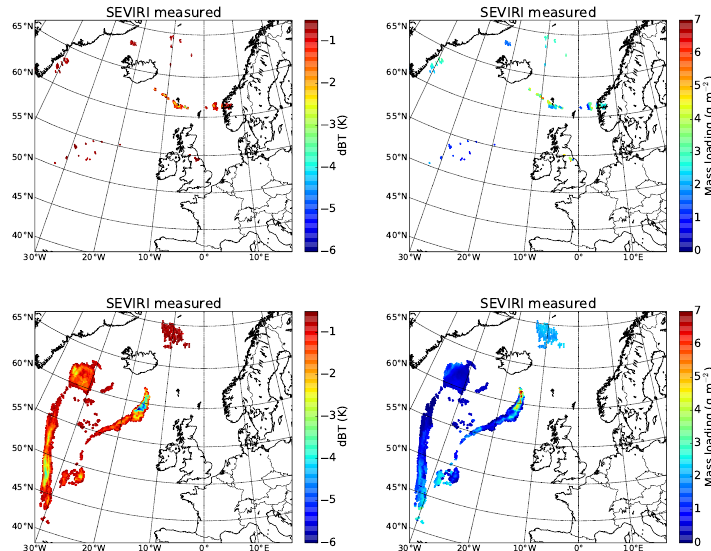
Figure 7. (Left plots) The (cid:49)T = T 10 . 8 − T 12 . 0 brightness temperature difference calculated from SEVIRI measurements. (right plots) The Figure7. (Leftplots)The ∆ T = T 10 . 8 T 12 . 0 brightnesstemperaturedifferencecalculatedfromSEVIRImeasurements.(Rightplots)The − ash mass loading retrieved from measured SEVIRI data. Data are for 1200 UTC, 15 April, 2010 (Upper plots) and 1800 UTC, 8 May, 2010 ash-mass loading retrieved from measured SEVIRI data. Data are for 12:00UTC, 15 April, 2010 (upper plots) and 18:00UTC, 8 May, 2010 (Bottomplots).Onlydatapointswith ∆ T < 0 . 5 Kareshown. − (bottom plots). Only data points with (cid:49)T < − 0 . 5K are shown.